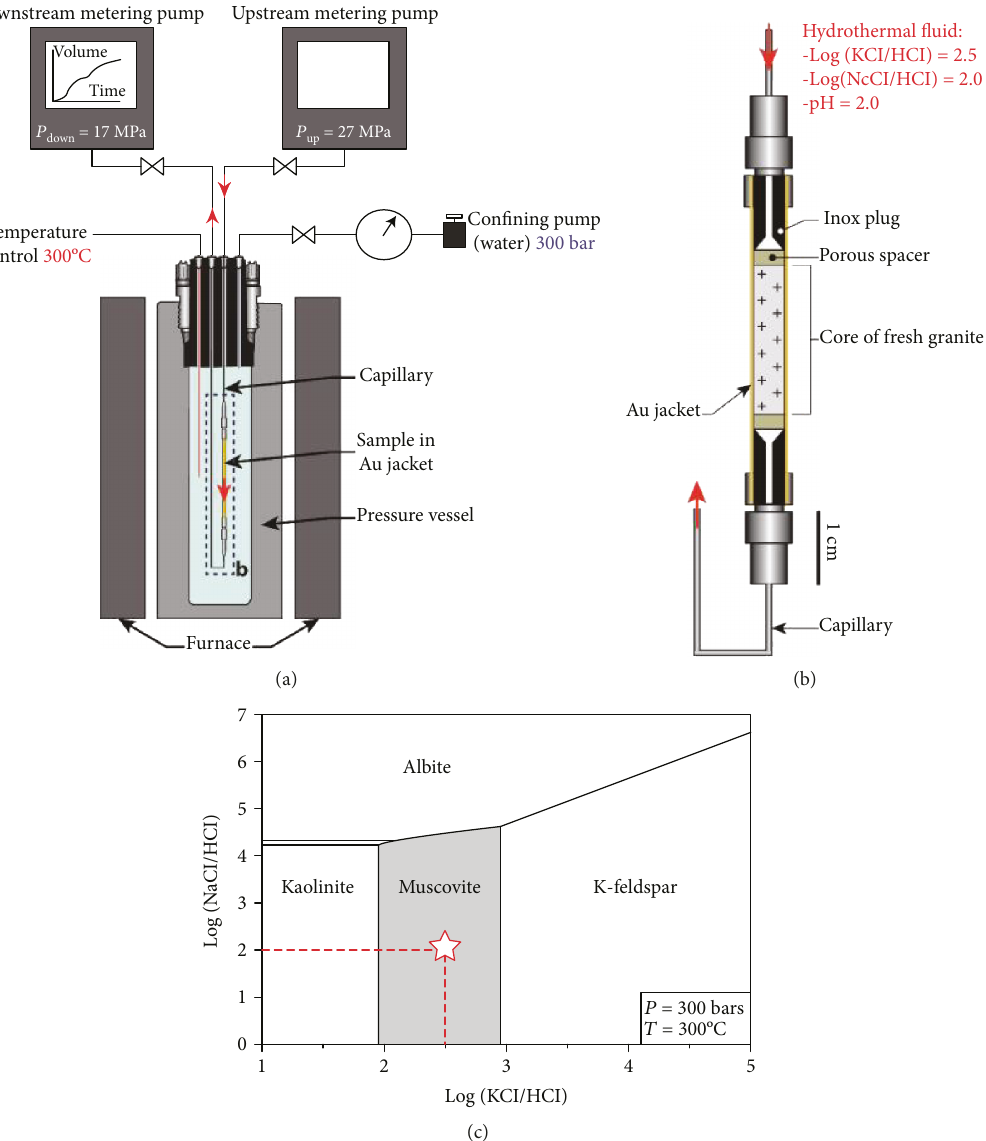
Figure 3: Apparatus used for the greisenization experiment coupled with permeability measurement. (a) External heated pressure vessel equipped with two metering pumps used for the pore- fl uid system and the permeability measurement. (b) Connection between the granite core (encapsulated in the Au jacket) and the pore- fl uid system. Red arrows give the sense of fl uid fl ow in the pore- fl uid system. (c) log(NaCl/HCl) vs. log(KCl/HCl) diagram showing the stability fi elds of albite, muscovite, and K-feldspars under the experimental conditions used for the greisenization experiment (300 ° C and 300 bar). The white star indicates the composition of the starting solution used for the experiment. This diagram was established from the SUPCRTLB thermodynamic database [46,